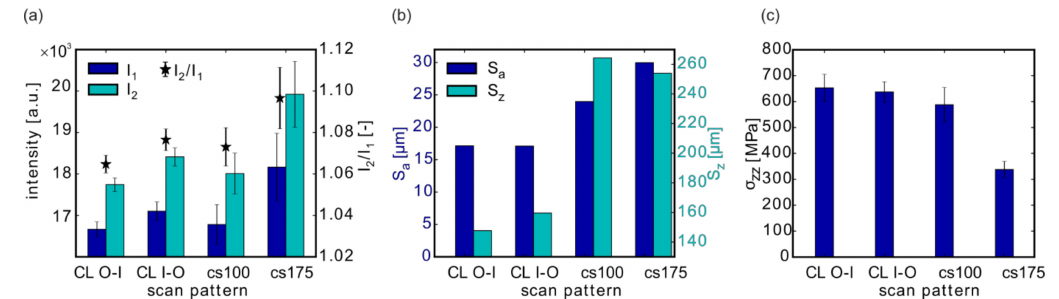
Figure 5. Influence of the scan pattern on the MPM data ( a ), on the surface roughness ( b ), and on the residual stresses ( c ). Depicted results are from samples #01 (CL O-I), #02 (CL I-O), #03 (chess scan strategy with P = 100 W), and #04 (chess / P = 175 W). CL O-I, contour lines from the outside to the inside; CL I-O, contour lines from the inside and finishing with the outside.